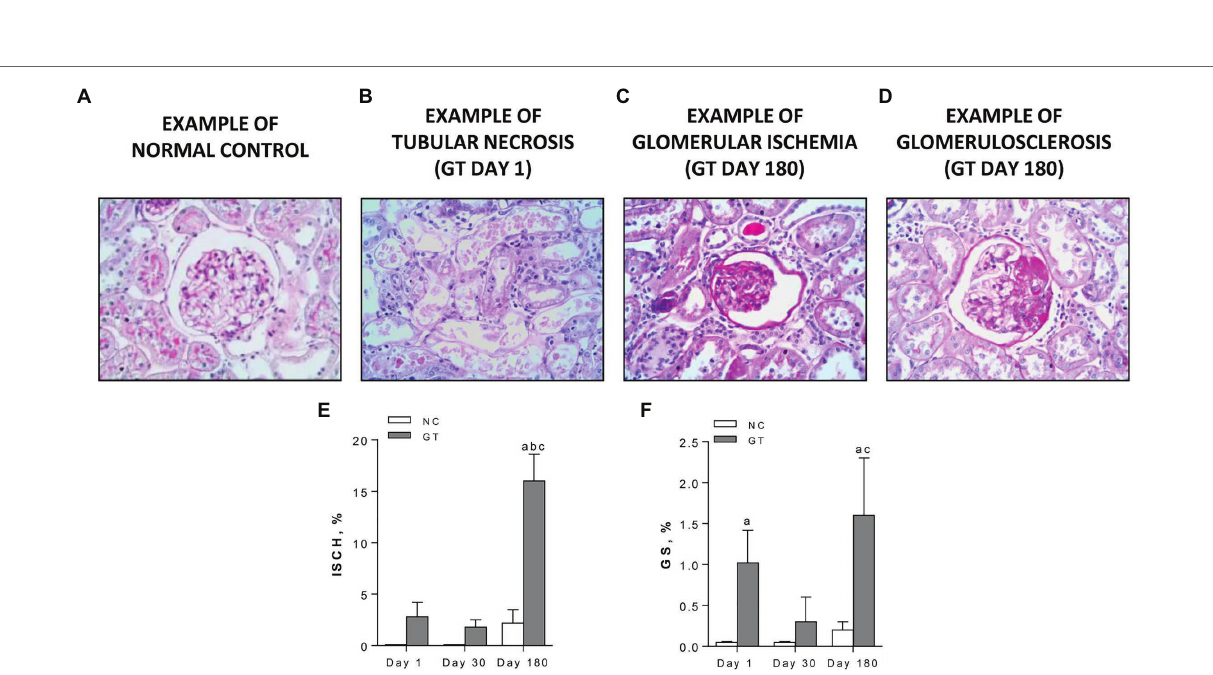
FIGURE 3 | Representative microphotographs of renal lesions (PAS-stained, 400×) (A) normal glomerulus; (B) widespread acute tubular necrosis, present on Day 1 only, with tubular profiles nearly completely devoid of cells and filled by necrotic material; (C) a representative ischemic (ISCH) glomerulus, showing tuft collapse, wrinkled basement membrane, and closure of capillary loops, on Day 180; (D) a representative glomerulus with a segmental sclerotic lesion (GS), with occlusion of capillary loops by a hyaline material, on Day 180; and (E,F) quantitative analysis of ISCH and GS, respectively, in groups NC and GT. Results expressed as means ± SE . a p < 0.05 vs. NC, b p < 0.05 vs. Day 1, and c p < 0.05 vs. Day